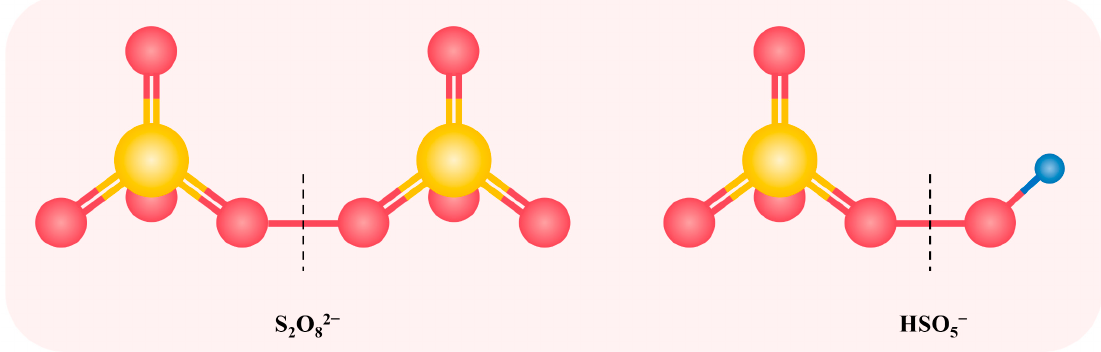
Figure 1. The structure of PDS and PMS. Yellow color is the sulfur atom and the red color is the oxygen atom. Dashed line represents the fission position of O–O bond for the formation of sulfate radicals.